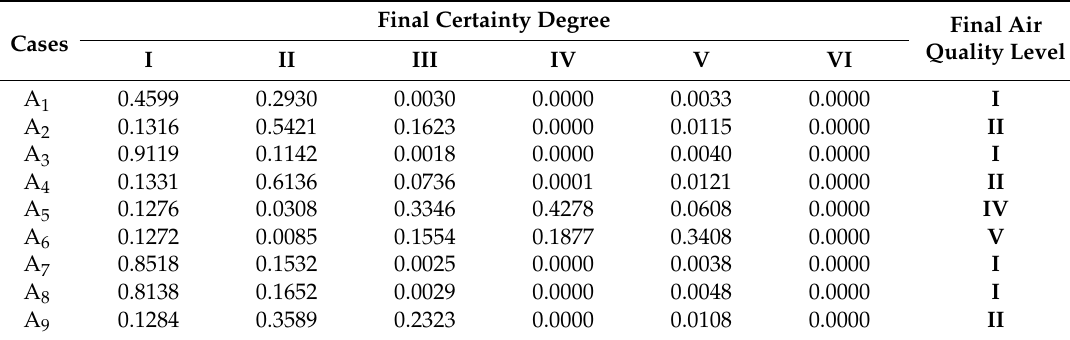
Table 14. The final results of evaluation for air quality.